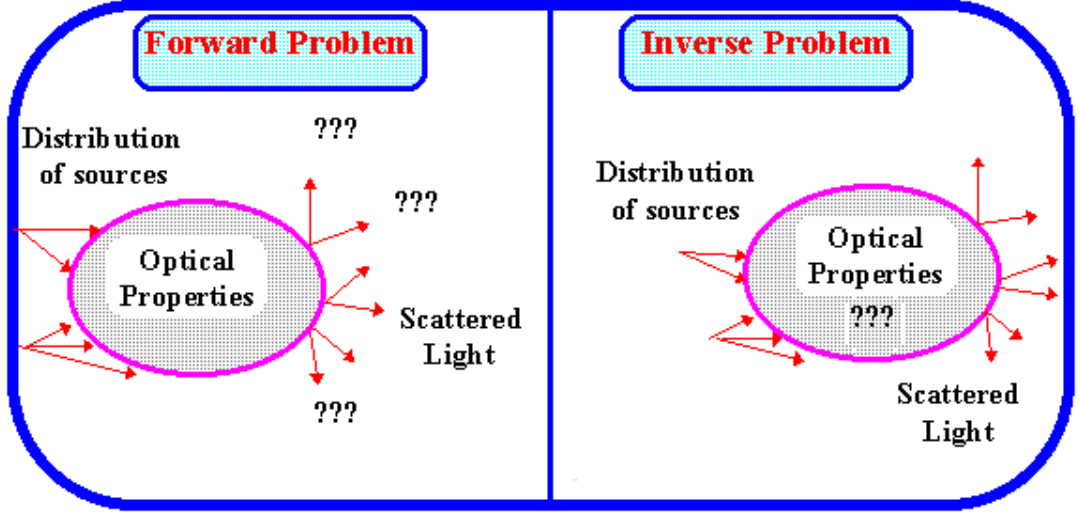
Figure 1. Illustration of forward problem and inverse